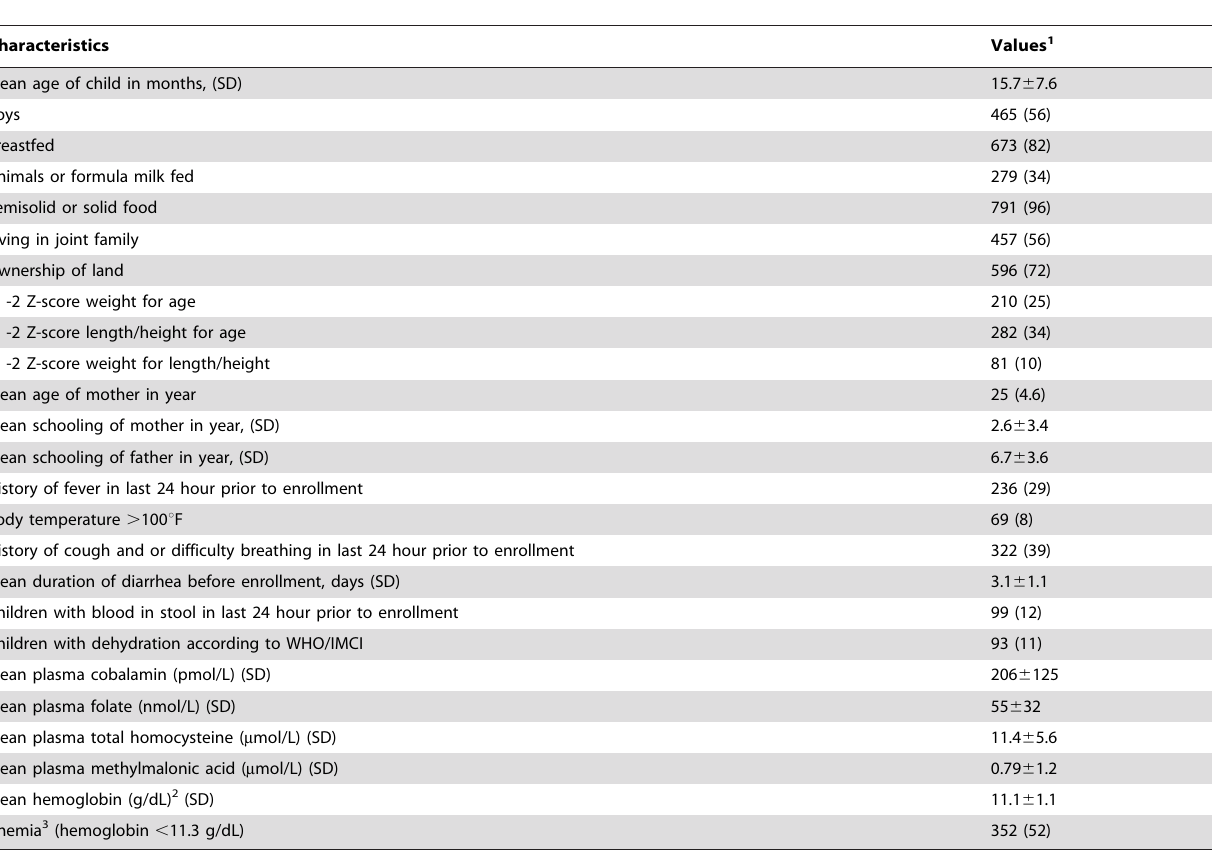
Table 2. General and clinical characteristics of 823 study children with acute diarrhea in Bhaktapur, Nepal.